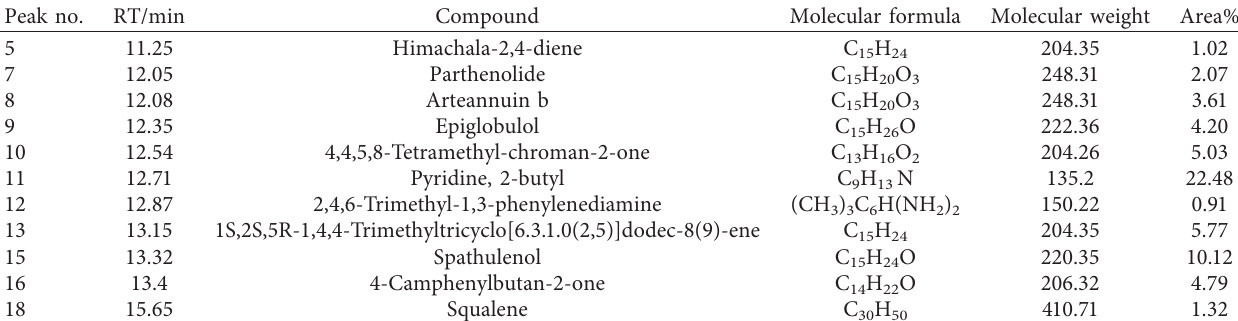
Table 6: Interpretation of GC-MS analysis: identified compounds that are contained in EHX only. Peak no.